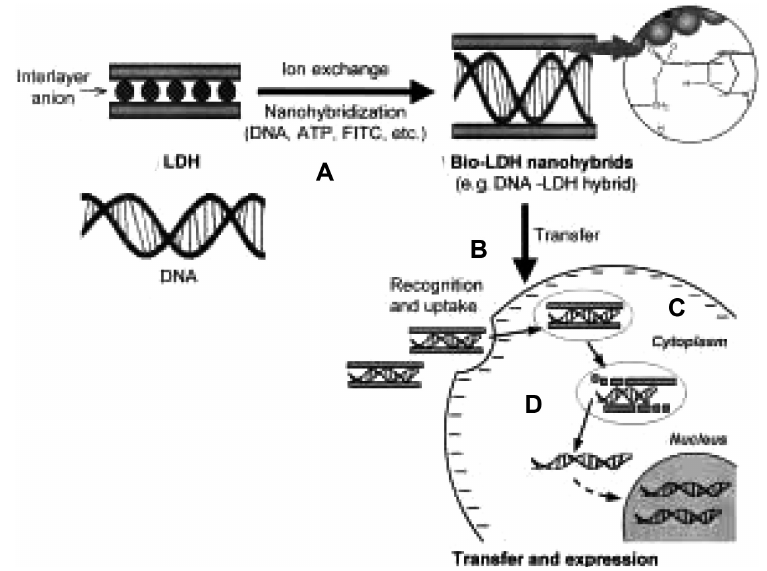
Figure 7 Hybridisation and transfer mechanism of LDH nanoparticles. (A) Anion exchange between interlayer NO 3- or Cl - anions and negatively charged biomolecules, for example, DNA, leads to the formation of LDH-nanobiohybrids. (B) Uptake via receptor-mediated endocytosis. (C) Acidification of the endosome causes LDH particles to